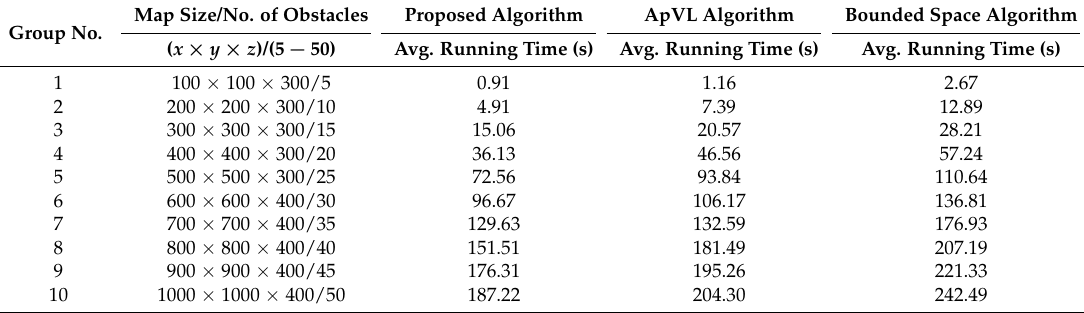
Table 1. Description about the maps used in experiments and operating environment modelling results. Group